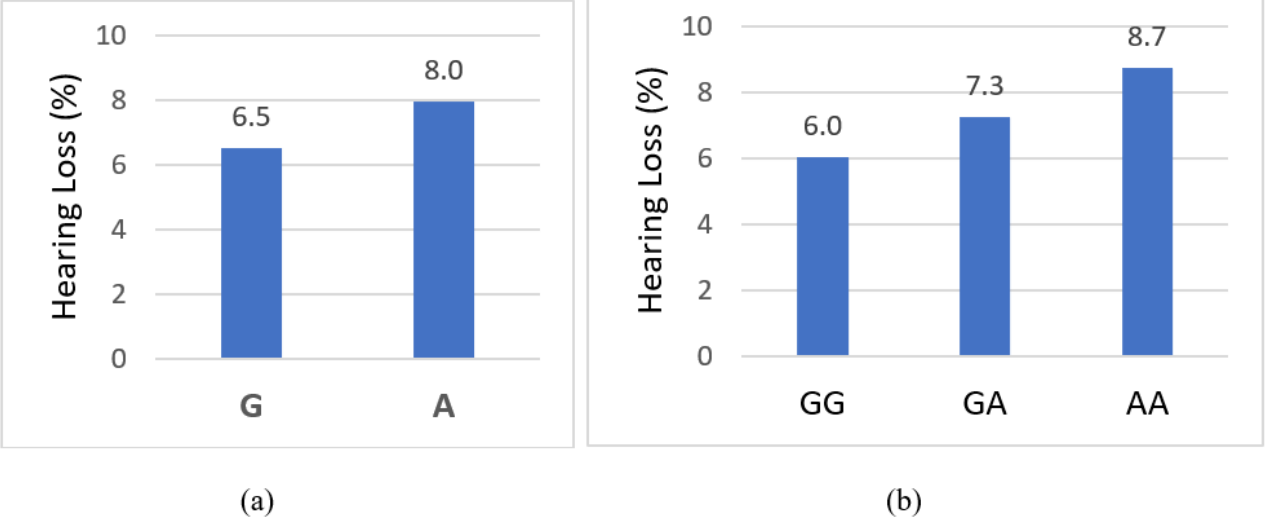
Figure 1. Prevalence of hearing loss by allele and genotype of rs4680 (a missense variant in catechol- O-methyltransferase): ( a ) allele; ( b ) genotype.